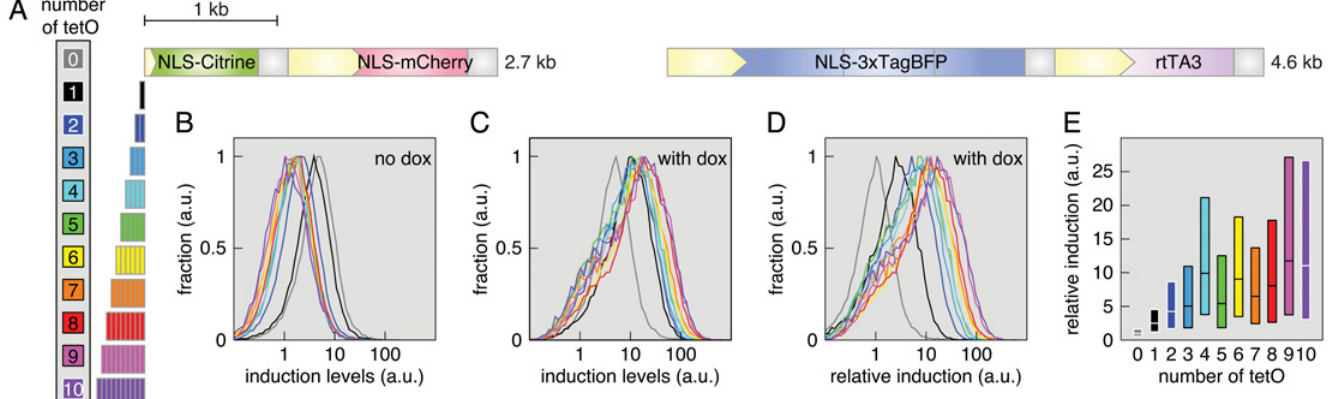
Fig 5. Varying the number of tetO sequences to titrate doxycycline-inducible transgene expression. (A) Scheme of the reporter constructs containing 0 – 10 tetO elements and the construct expressing the reverse tetracycline transcactivator (rtTA). Scale bar: 1 kb. (B) Distribution of reporter signal in uninduced (no doxycycline added) HeLa cells measured by flow cytometry. Lines are color-coded according to the legend depicted in (A). (C) Distribution of reporter signal in induced (doxycycline added 24 h before analysis) HeLa cells. (D) Distribution of reporter signal in induced HeLa cells normalized by the background levels for each reporter construct. (E) Box plot showing the normalized reporter signal for each reporter construct.